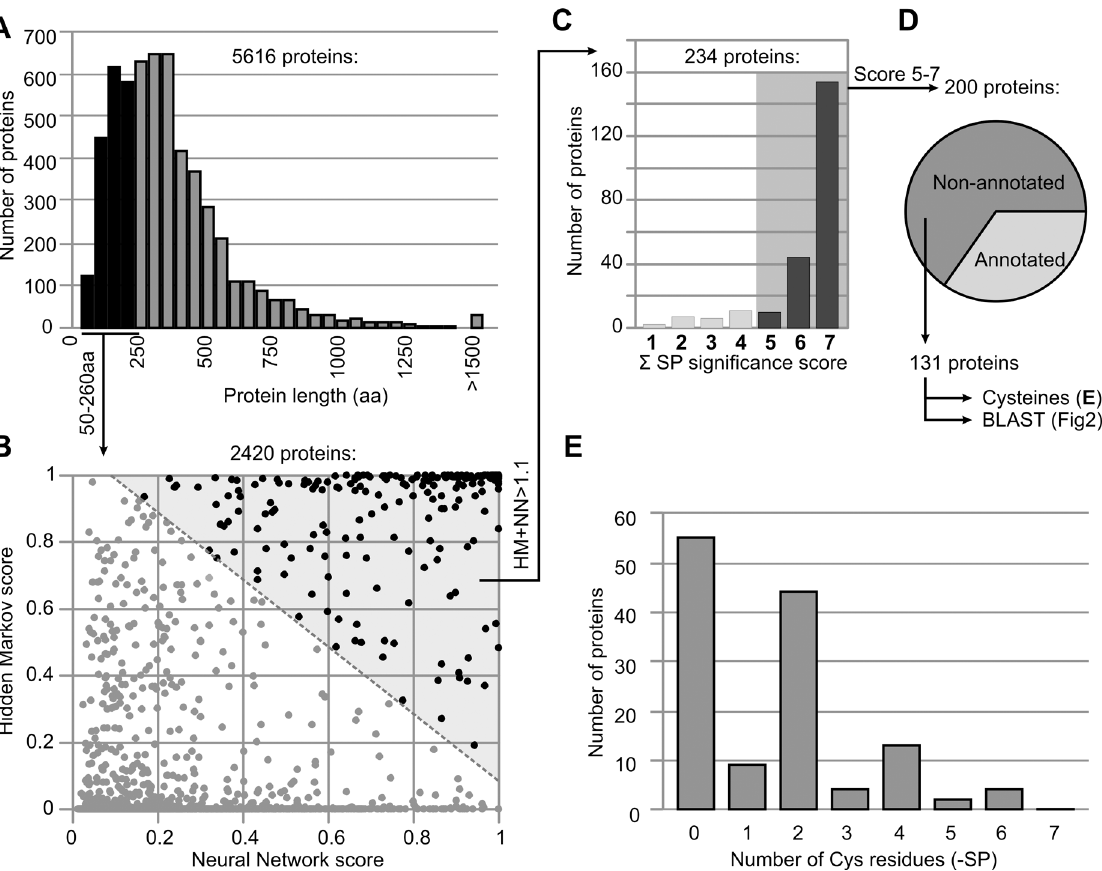
Fig 1. In silico selection of small, secreted, non-annotated proteins of PtoDC3000. (A) Selection of small proteins. 5616 proteins encoded by the PtoDC3000 genome were ranked based on amino acid length. 2420 proteins with 50 – 260 amino acid length were selected. (B) Selection of secreted proteins. 2420 small proteins were plotted with their SignalP scores for both Hidden Markov (HM) and Neural Network (NN). 243 proteins with HM+NN > 1.1 were selected. (C) Selection of significant signal peptide (SP) prediction scores. For each of the 243 proteins, significance scores for both HM and NN algorithms were added up and 200 proteins with scores of 5 or higher were selected. (D) Selection of non-annotated proteins. Annotations in the genome database were used to select 131 non-annotated proteins. (E) Number of Cys residues in the selected 131 mature proteins. The predicted signal peptide was removed from the sequence and the number of Cys residues in the remaining protein was counted and plotted in a frequency